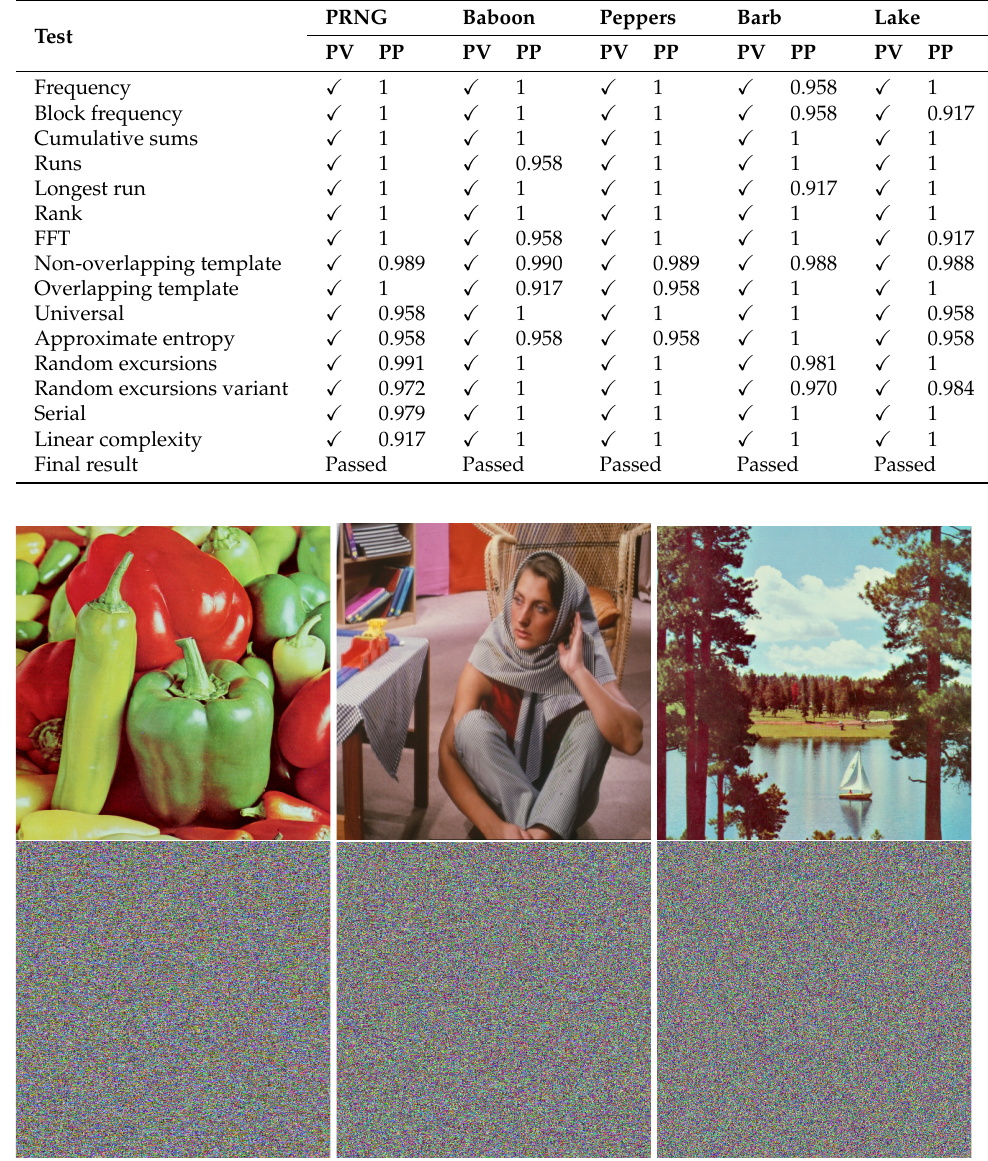
Figure 5. Plain and encrypted Peppers, Barb and Lake